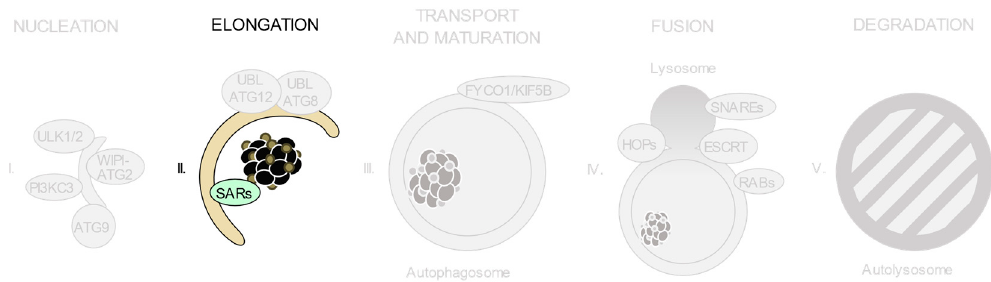
Figure 7. The autophagy receptors (SARs) participate in selective cytoplasmic cargo recognition (i.e., protein aggregates as depicted in the figure) during pre-autophagosomal membrane elongation.